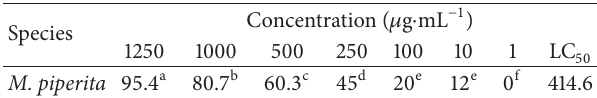
Table 3: Results of the mortality of M. piperita front toxicity test against larvae of A. salina .